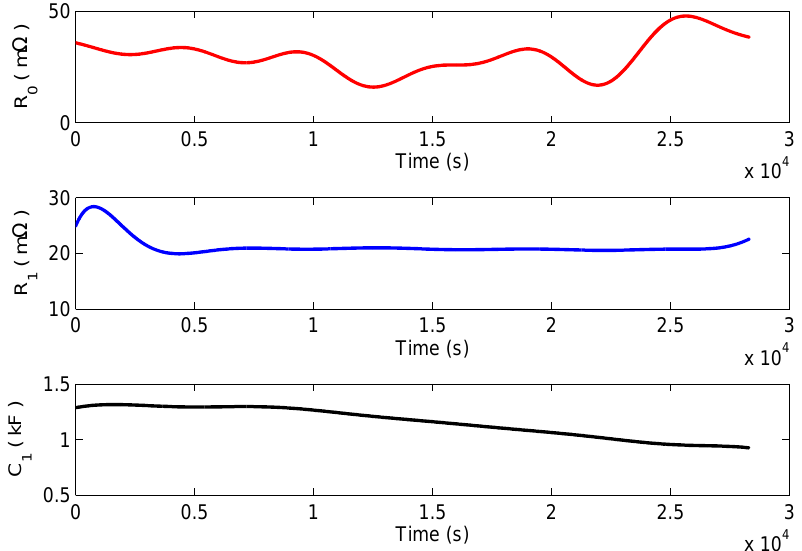
Figure 11. Results of parameters identification using VB-ADEKF in the UDDS